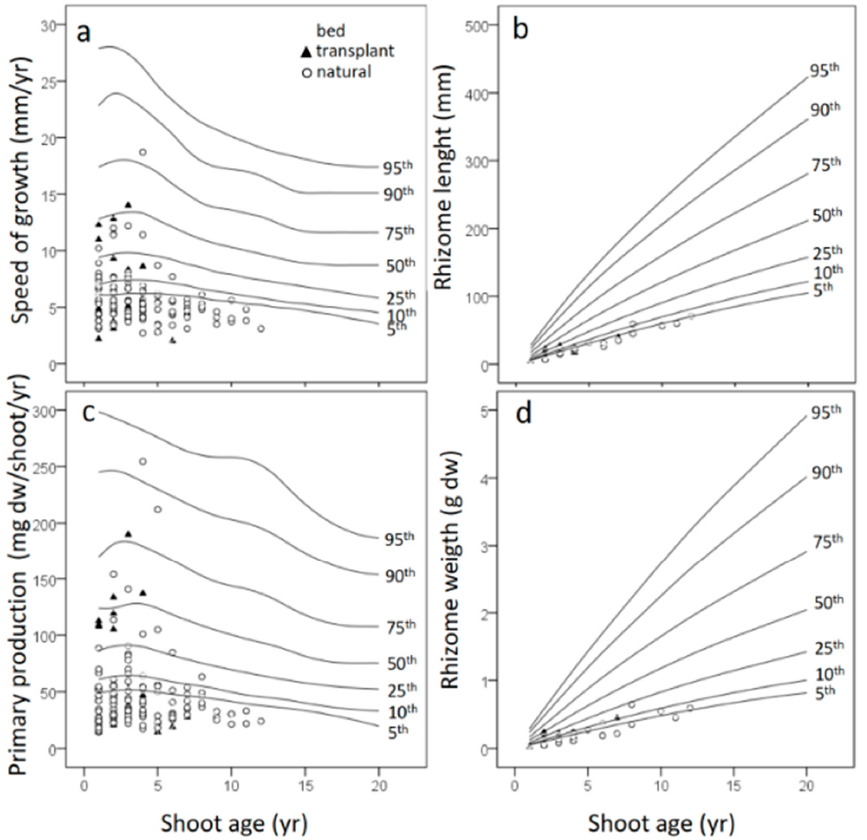
Figure 9. Growth performance measurements plotted on reference growth charts. The distribution of speed of growth of rhizomes ( a ), rhizome length ( b ), primary production ( c ) and weight ( d ) of the two beds are compared with the expected percentile curves at different ages.